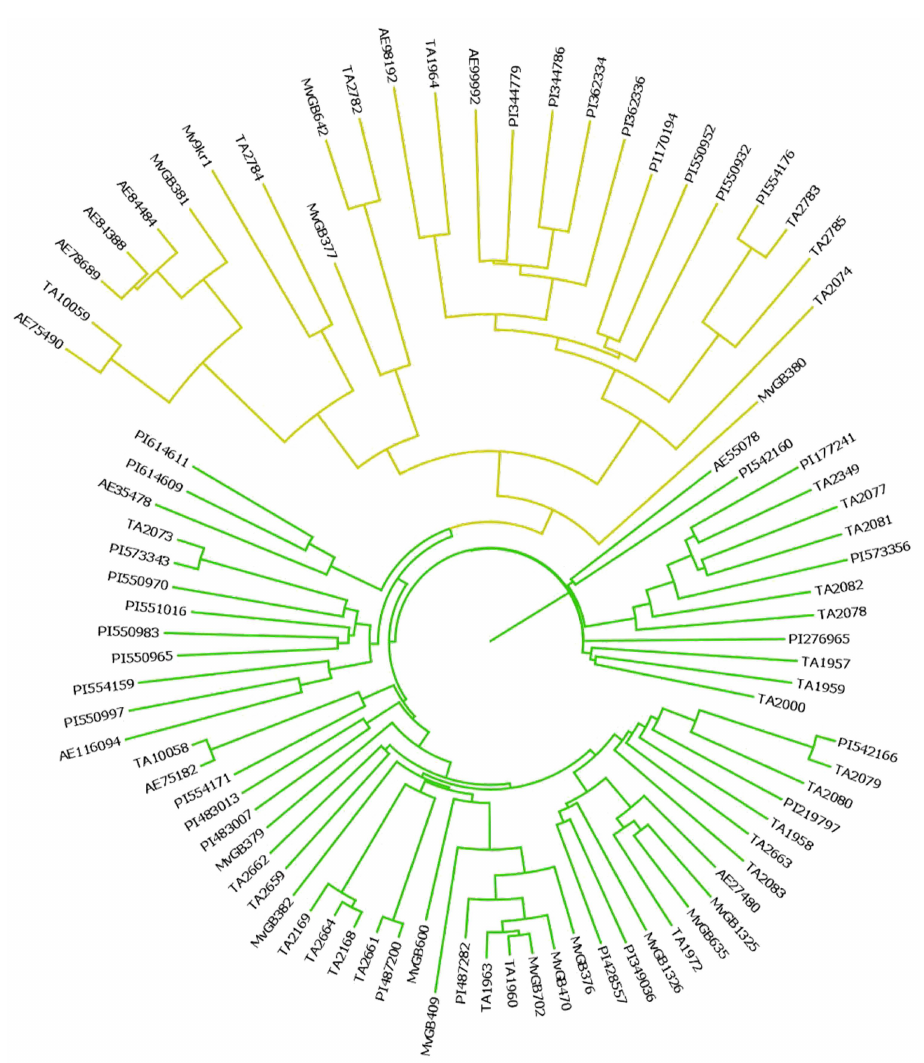
Figure 4. Unrooted Bayesian tree of the Ae. biuncialis collection created with the bootstrap method and 1000 replications on the data set of 2602